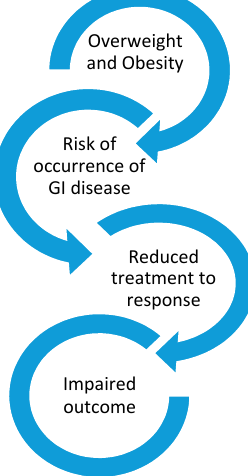
Figure 1. Relationship between obesity occurrence of gastrointestinal (GI) disease and impaired clinical outcome.